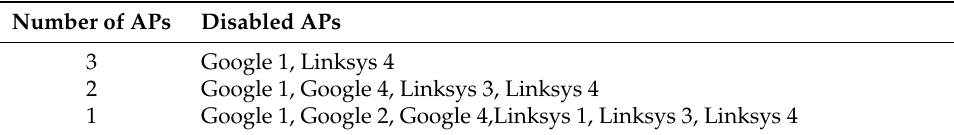
Table 7. Sequence followed for switching-off the APs.